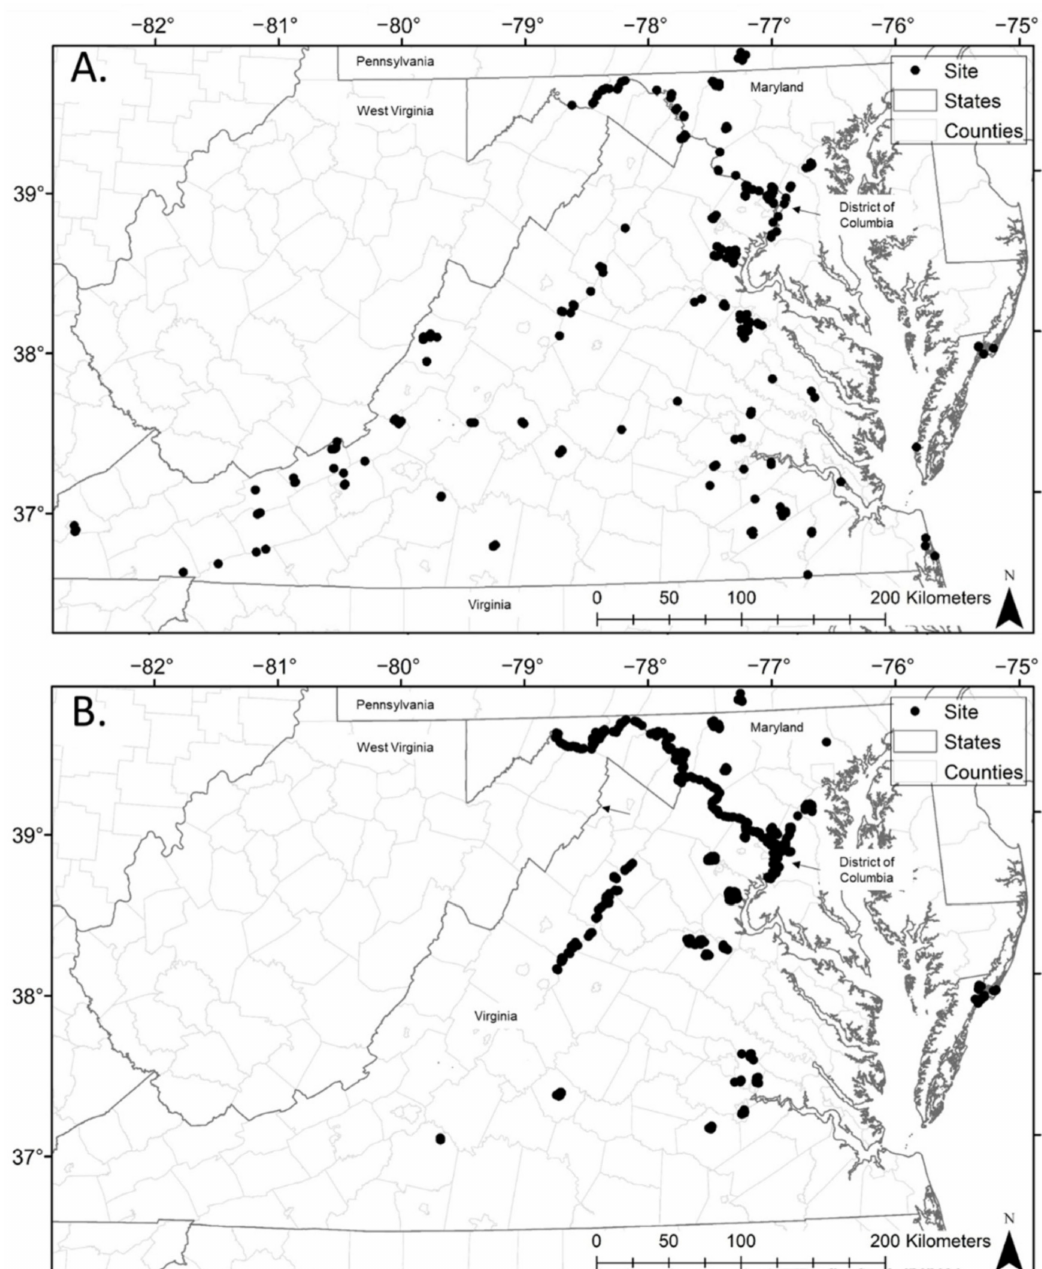
Figure 1. Mid-Atlantic sampling sites where ( A ) reproduction and ( B ) call data were collected between 2015 and